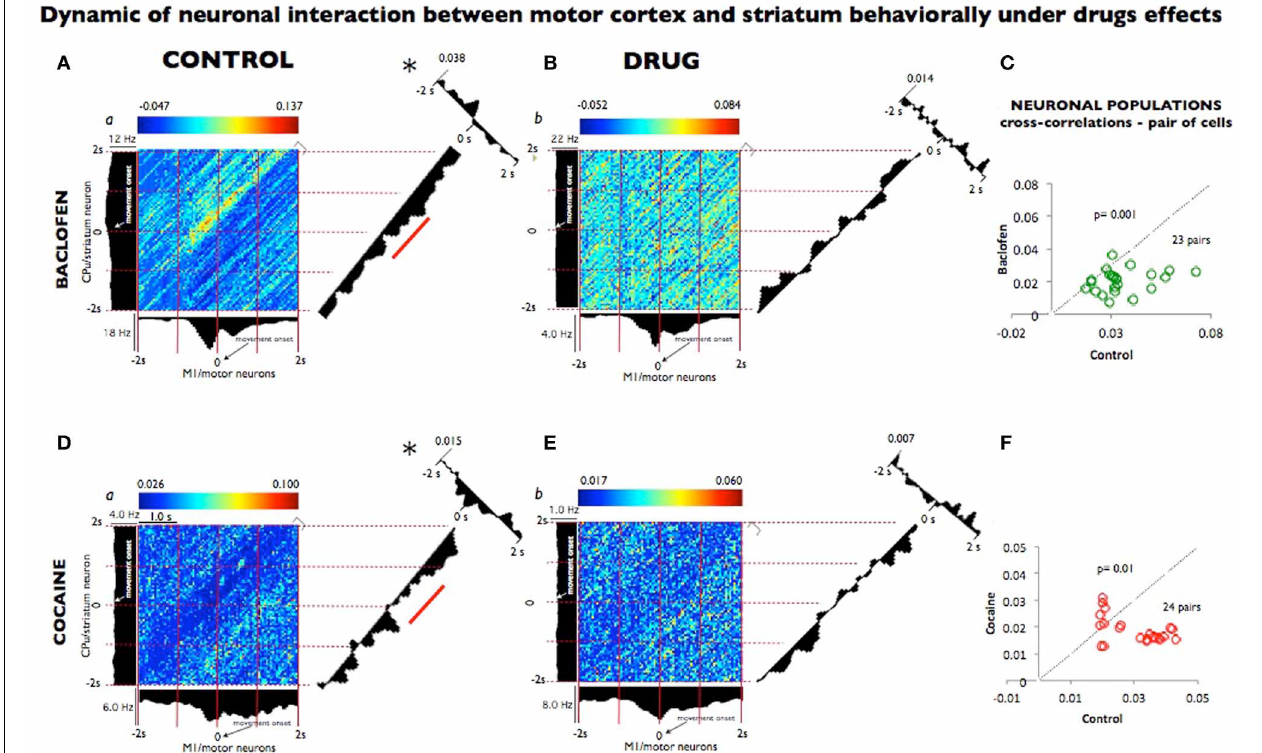
FIGURE 4 | Dynamic relationship of neuronal pairs from motor cortex and striatum modulated during control vs. drug conditions. (A) Joint peri-stimulus time histograms (JPSTHs) constructed (Vaadia et al., 1995) from pairs of neurons in the motor cortex and in the striatum, which were respectively recorded during nondrug (control) conditions for 0.5h in 53 trials. The color-coded pixels of the matrix represent the normalized correlation coefficient of neuronal peak. Each bin size corresponds to the correlation of the two neuron pairs as a function of coincidence in time. The (blue/red) color scales represent the mini and max integration, respectively, which is proportional to synaptic strength. The time windows are depicted on the right corner of each matrix. The firing rate (Hz) for each neuron pair is shown on the left and top of the respective motor striatum histograms. The diagonals (representing the coincident firing) show the 2s window period sampled and binned at 50ms from both neurons during the match phase in the DMS task (Grid intervals, 1s). Each bin size corresponds to the degree of correlation between the two-neuron pairs within the same time bins as shown in the color scale above each plot (a). The diagonal of the JPSTH is the coincidence histogram, indicating the temporal evolution of the correlation in the color-coded “raw” JPSTH matrix between the plotted neuron pairs (abscissa, motor, and ordinate striatum). A bin size of 50ms was used to calculate correlations along both